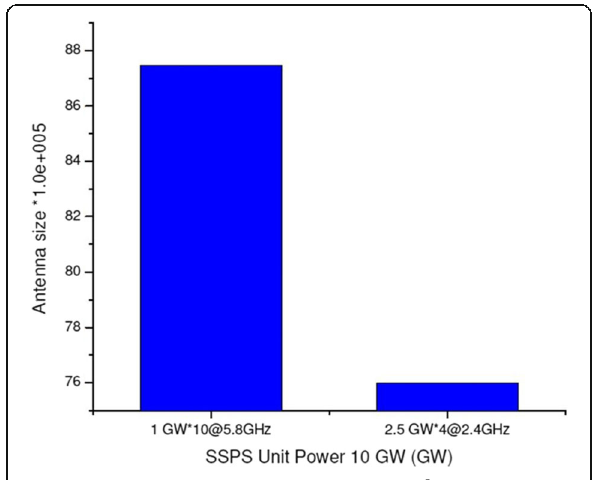
Fig. 8 Comparison assessment of antenna size (m 2 )